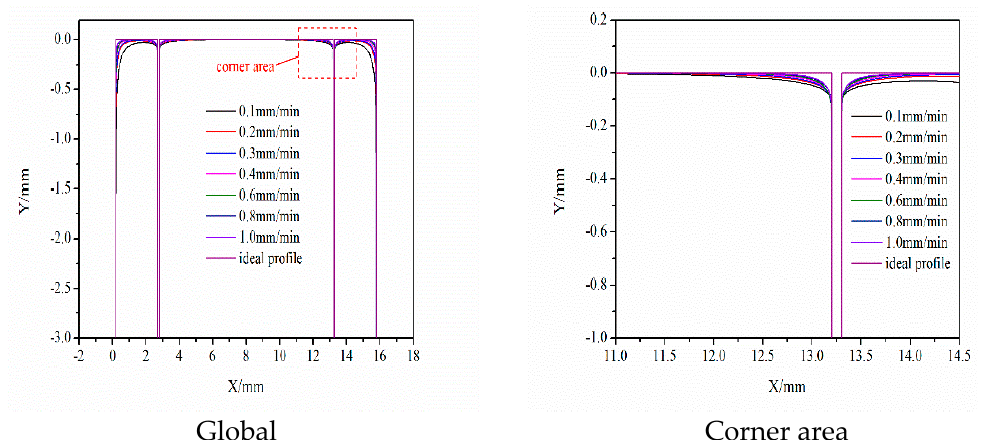
Figure 9. Contours of the workpiece in the proposed method.